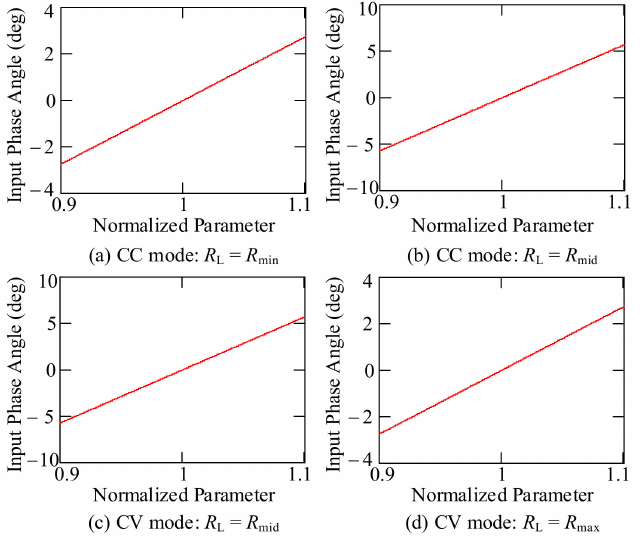
Figure 21. Inputphaseangleversusnormalizedparametersattwochargingmodesandtwo